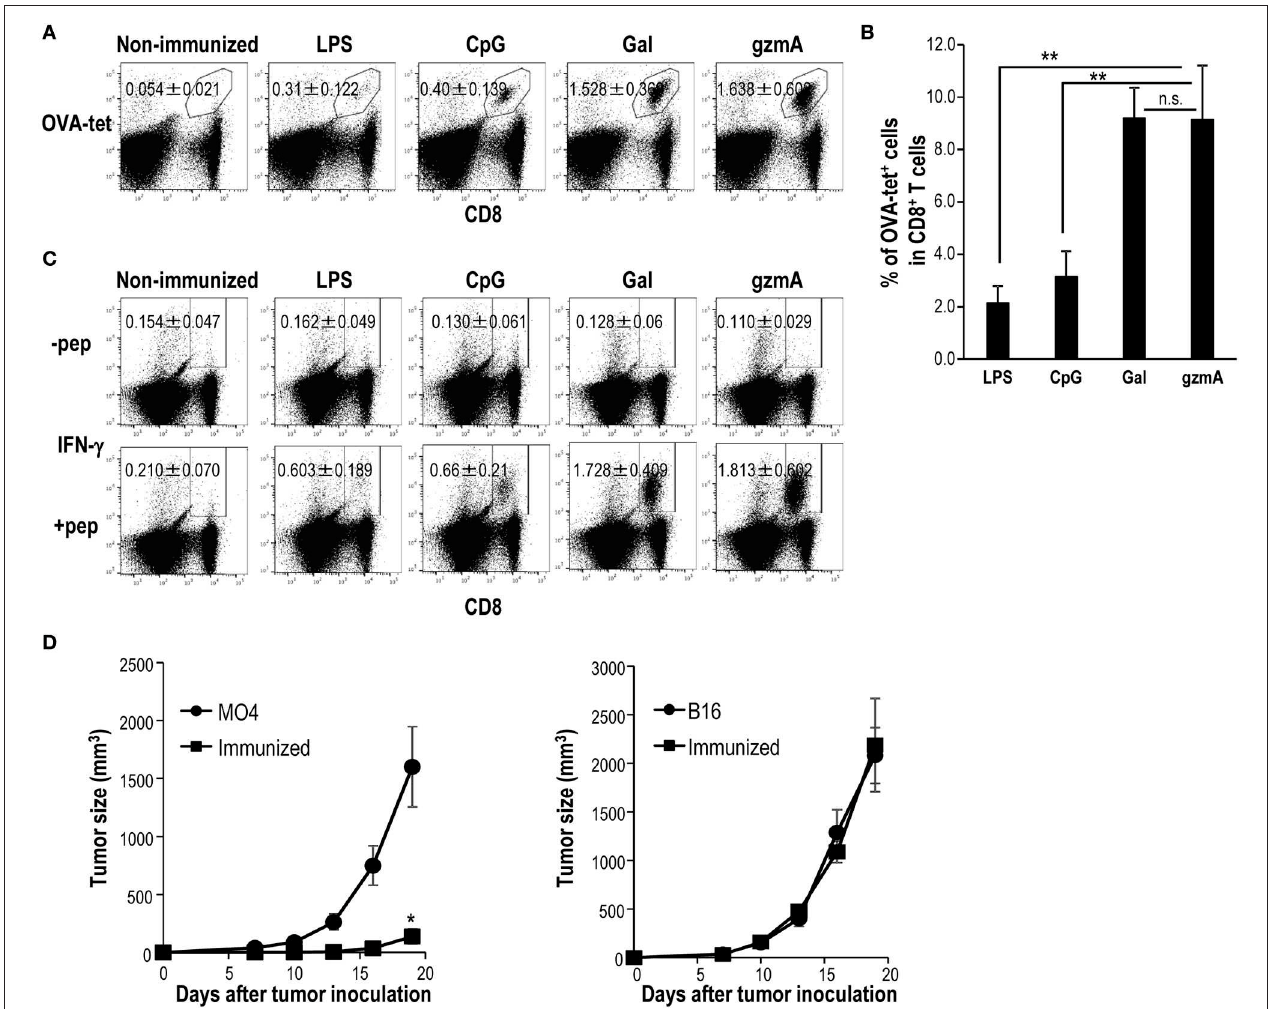
FIGURE 8 | Adjuvant effect of GzmA on antitumor cellular immunity. (A–C) CD8T cell response by different adjuvants. C57BL/6 mice were immunized intravenously with T/O together with LPS (20 µ g/mouse), CpG-ODN (30 µ g/mouse), α -GalCer (2 µ g/mouse) or GzmA (20 µ g/mouse). The frequency (A,B) and IFN- γ production (C) of OVA-specific CD8 + T cells in spleen were analyzed by flow cytometry on day 7. All data in (A–C) are representative of three independent experiments with similar results (mean ± SEM, n = 5) ** < p < 0.01 ( GzmA vs. others, Steel’s Many - one Rank Sum test) (D) The anti-tumor adjuvant effect of GzmA. Mice were immunized with T/O cells together with GzmA (20 µ g/mouse). One week later, mice were challenged with OVA-expressing B16 (MO4) or B16 (1 × 10 5 /mouse) melanoma cells, subcutaneously. The size of growing tumors was measured at the indicated time points ( n = 5–6/group) . * p < 0.05